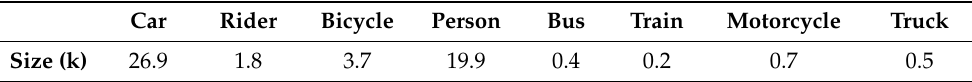
Table 2. The number of each instance class in the Cityscapes dataset.